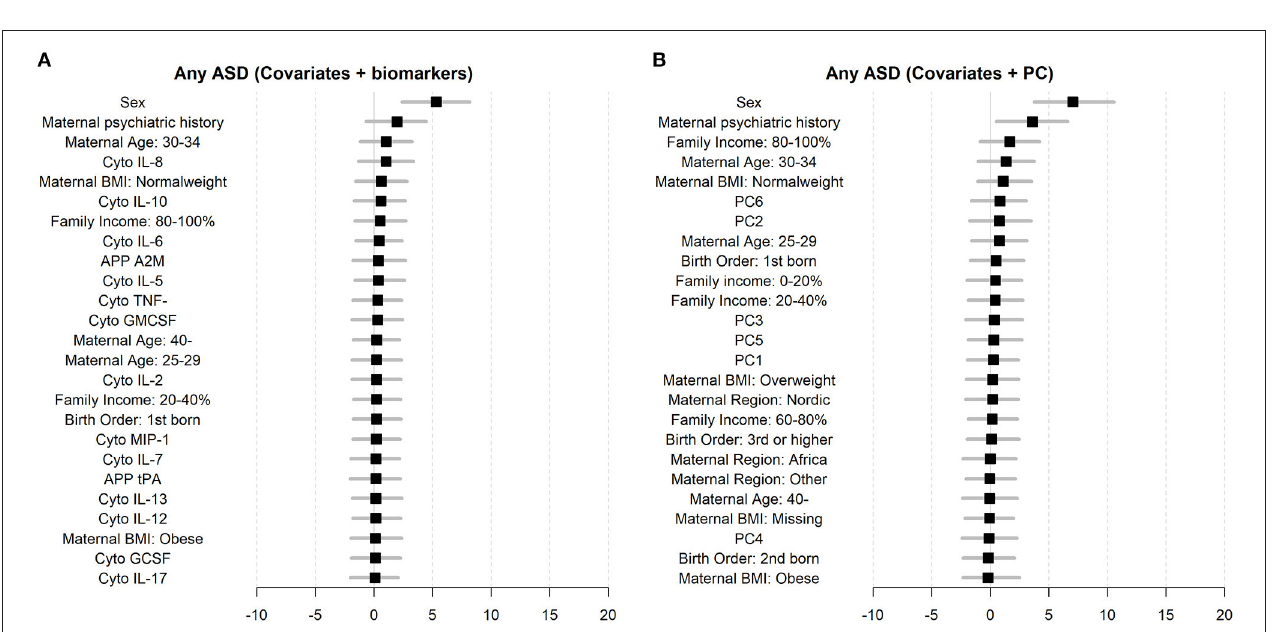
FIGURE 6 | Variable importance measures for biomarkers and registered covariates (A) , and the six largest principal components (PC1–PC6) and registered covariates (B)